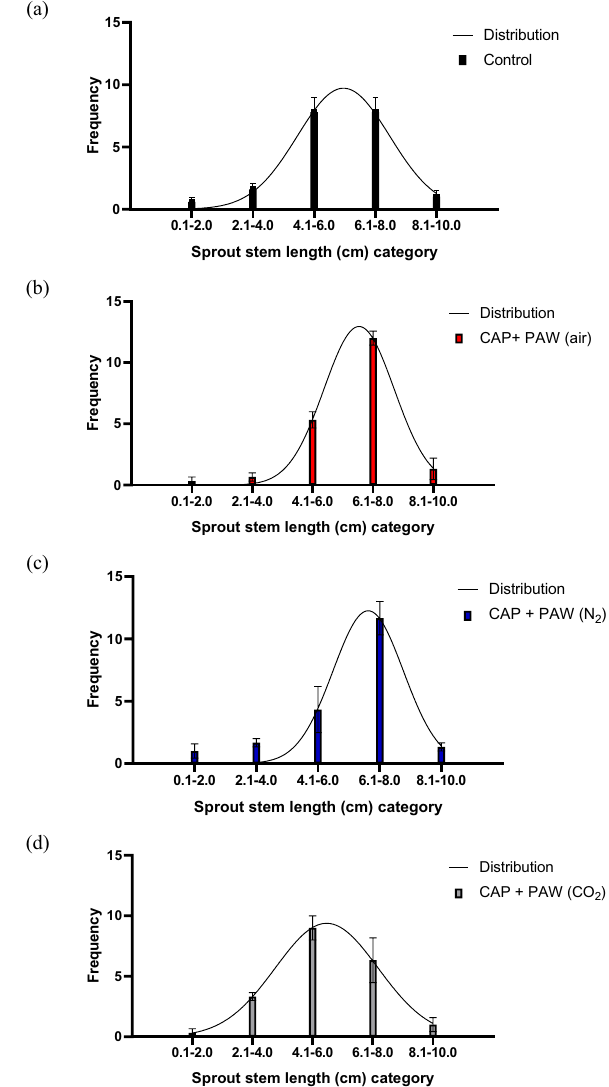
Figure 2. Frequency distribution of mung bean growth performance of the ( a ) control, ( b ) combined plasma treatment in air, ( c ) combined plasma treatment in N 2 and ( d ) combined plasma treatment in CO 2 . Sprouts were categorized according to stem length achieved within 96 h of growth. A Gaussian curve was fitted to demonstrate distribution (R 2 = ( a ) 0.7902, ( b ) 0.9607, ( c ) 0.8359, ( d )